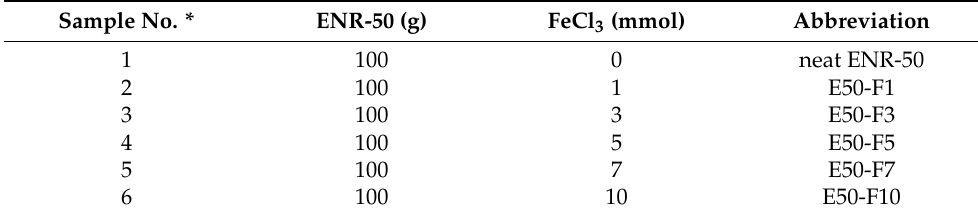
Table 2. Formulations of the elastomer composites. Sample No. * ENR-50 (g) FeCl 3 (mmol)